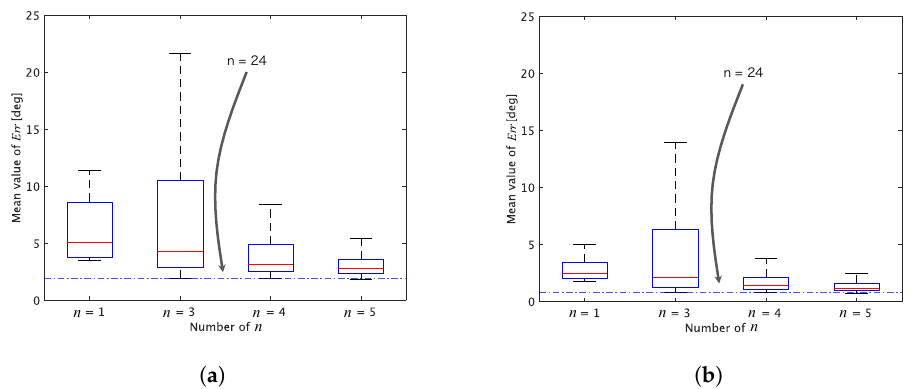
Figure 3. Box plots of mean values of reproduction errors for 24 patches. ( a ) Image in Figure 2b. ( b ) Image in Figure 2c. Boxes span from the first to third quartile, referred to as Q 1 and Q 3 . Whiskers show maximum and minimum values in range of [ Q 1 − 1.5 ( Q 3 − Q 1 ) , Q 3 + 1.5 ( Q 3 − Q 1 )] . The red band inside boxes indicates the